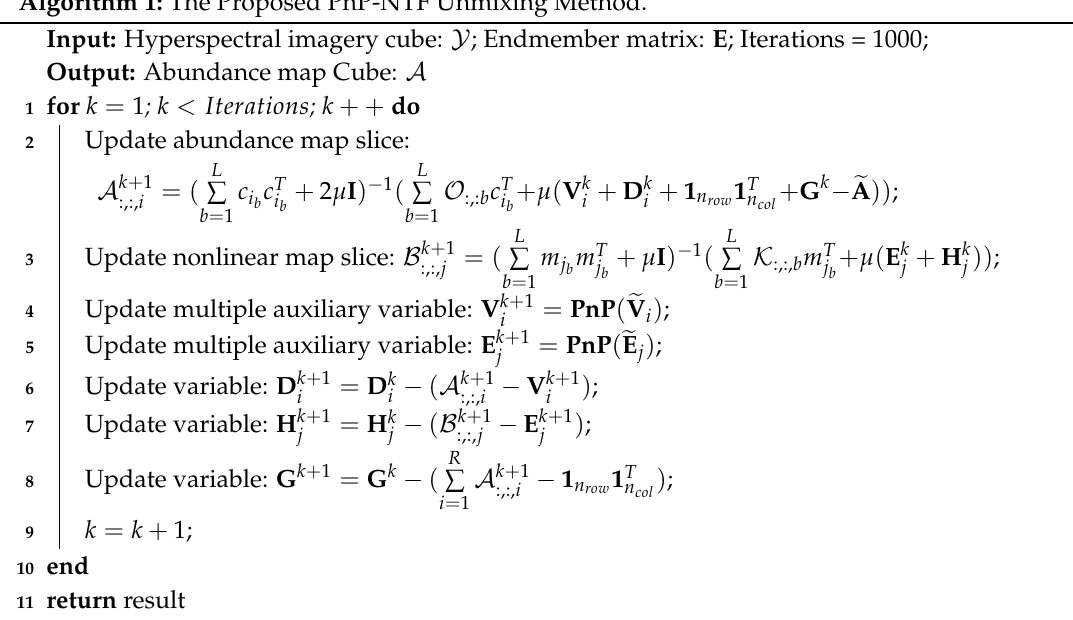
Algorithm 1: The Proposed PnP-NTF Unmixing